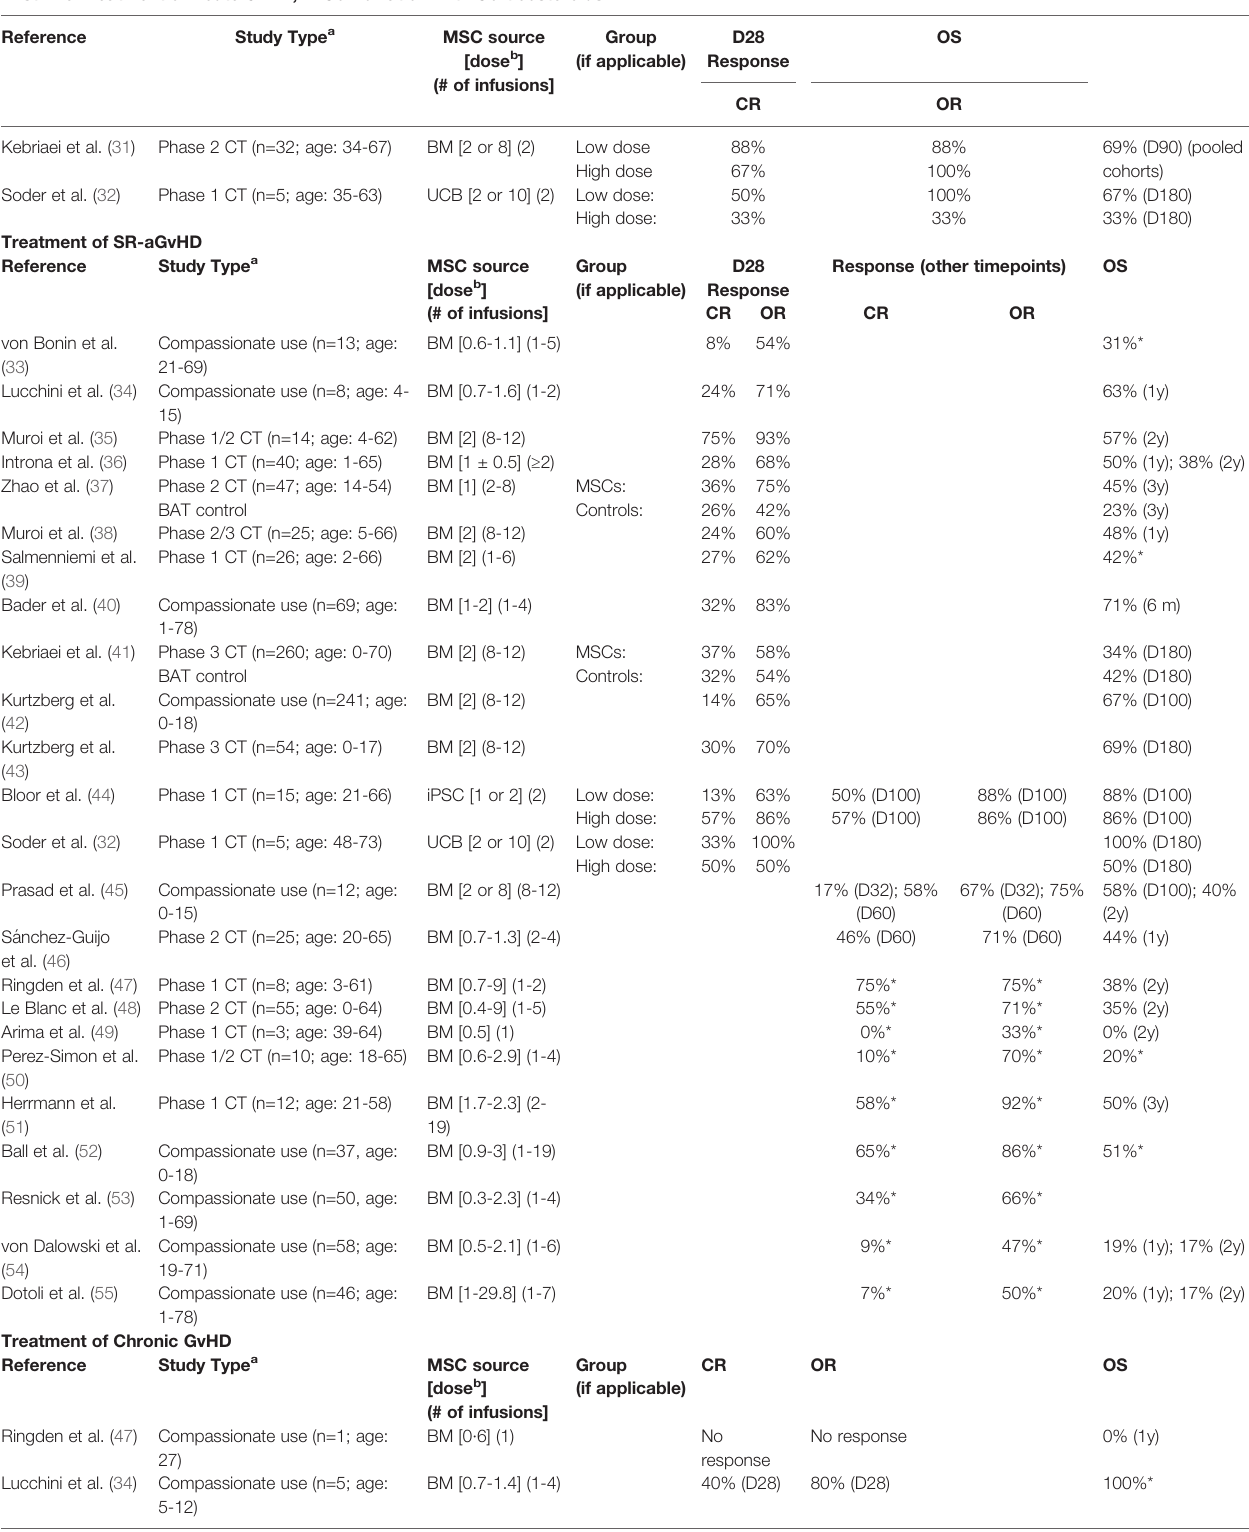
TABLE 2 | Summary of Published Clinical Studies of MSCs in GvHD. First-line Treatment of Acute GvHD, in Combination With